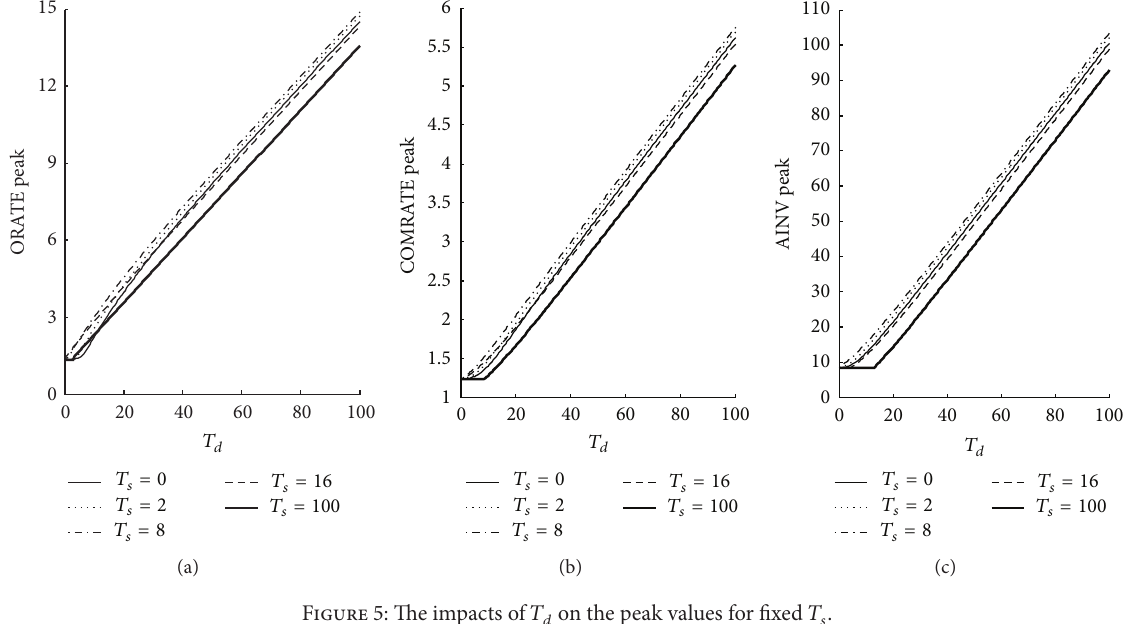
Figure 5: The impacts of 𝑇 𝑑 on the peak values for fixed 𝑇 𝑠 .